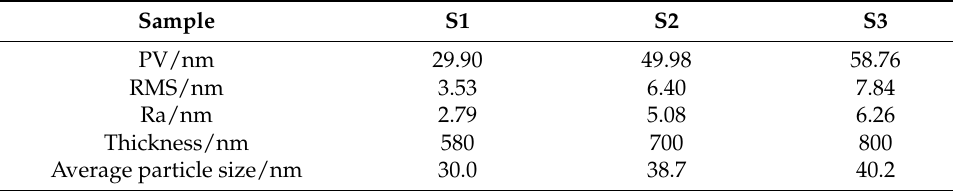
Figure 3. The SEM images of the films: ( a ) S1; ( b ) S2; ( c ) S3. Table 3. Roughness, thickness, and grain size of the